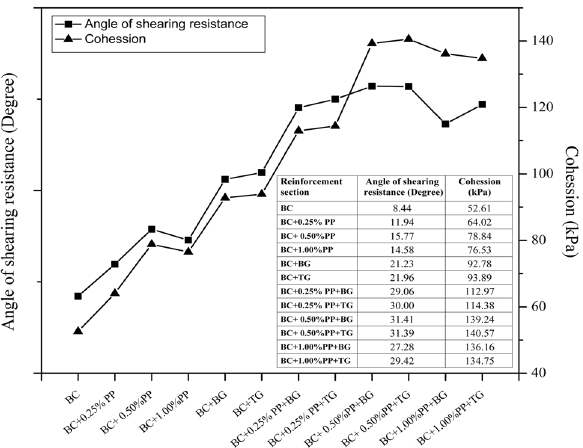
Figure 4. Cohesion and angle of shearing resistance of reinforced and unreinforced expansive subgrades.